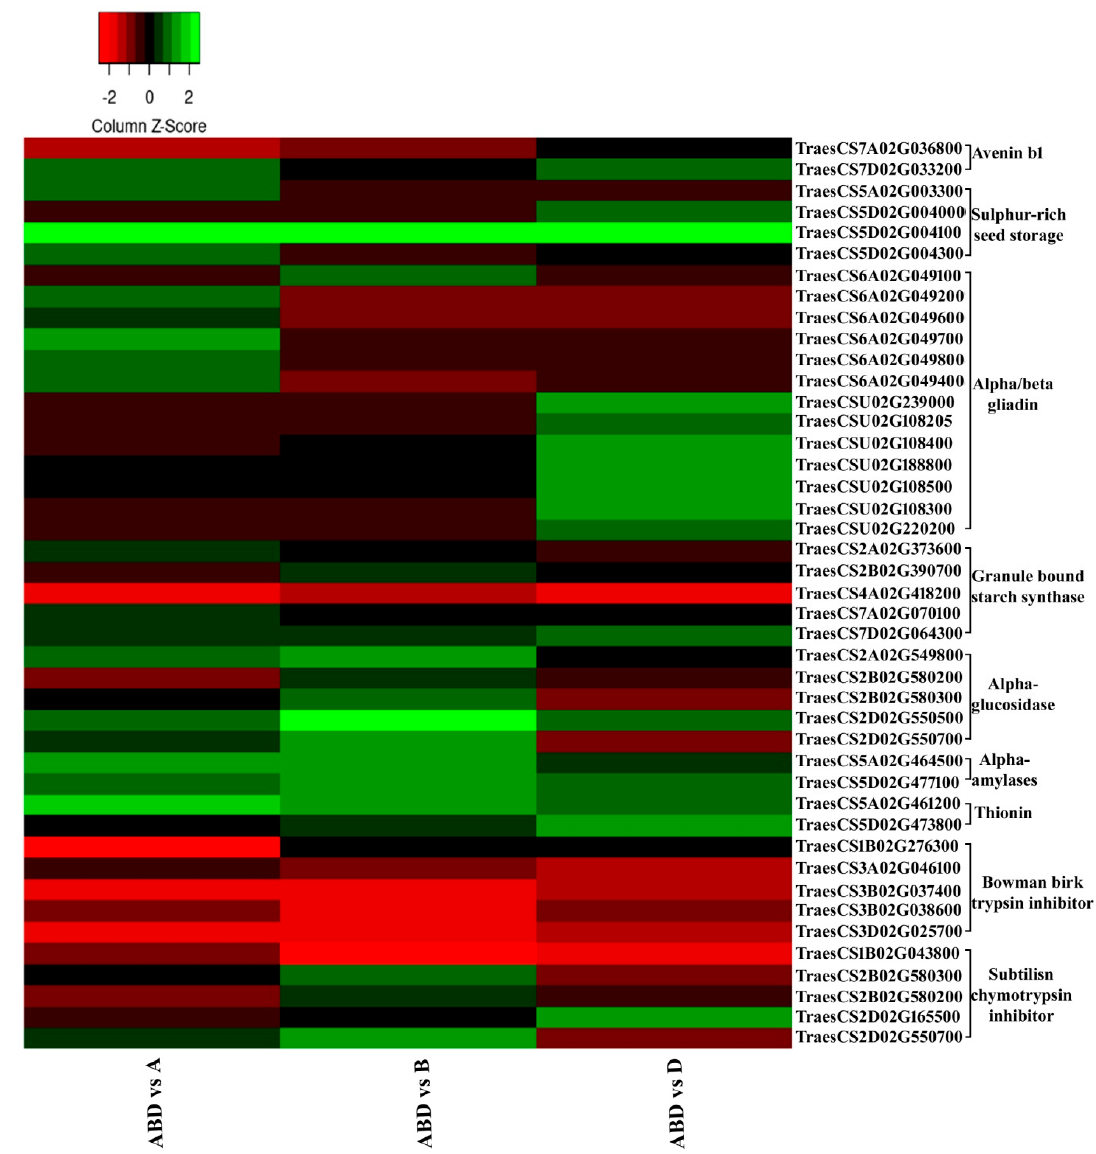
Figure 2. Heat map representing different transcripts having similar functions (green: up-regulated in hexaploid; red: up-regulated in diploids).